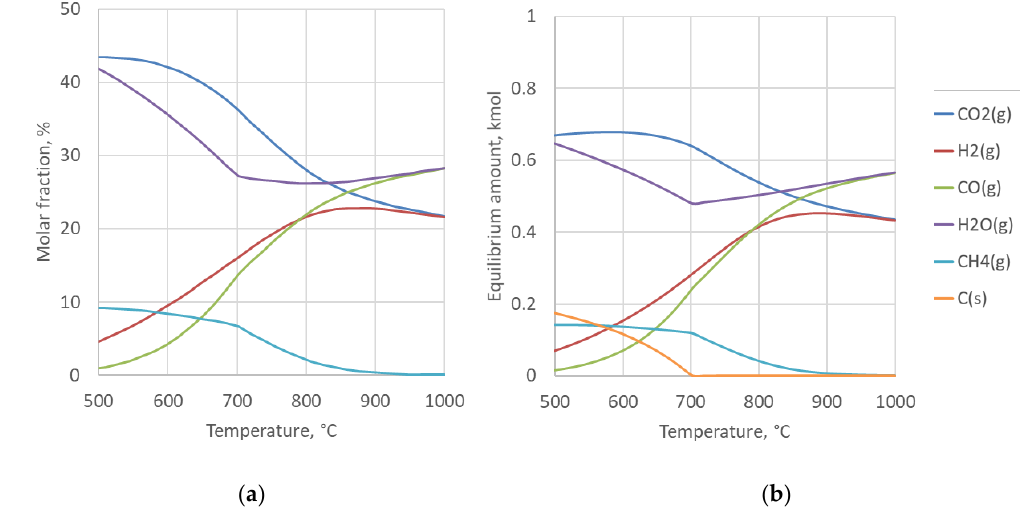
Figure 1. Equilibrium gas composition ( a ) and equilibrium amount ( b ) at 20 bar pressure as a function of temperature for the reverse water-gas shift (rWGS) reactor feed. Equimolar feed ratio of hydrogen (H 2 ) and carbon dioxide (CO 2 ). Results calculated with HSC Chemistry 9.